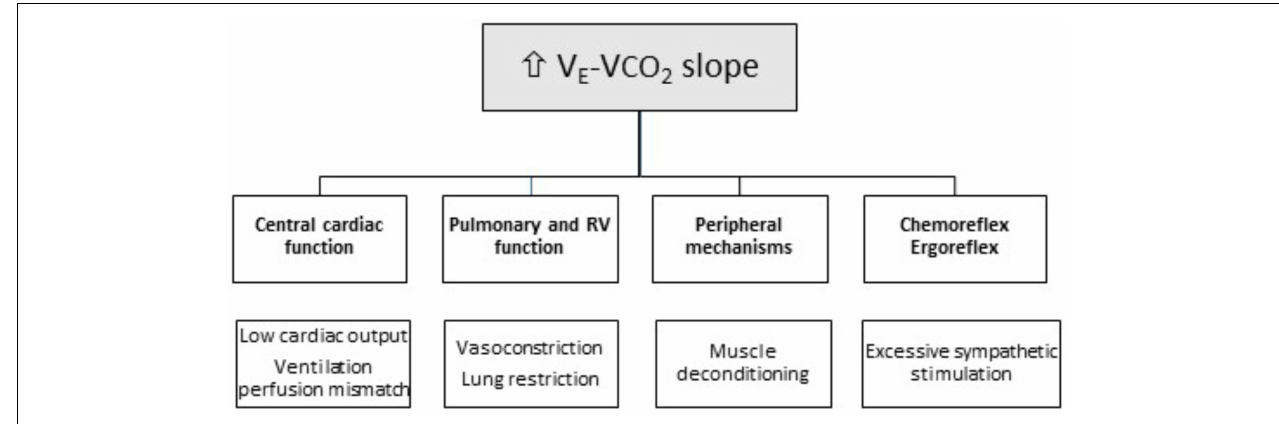
ATTR silencers ATTR stabilizers